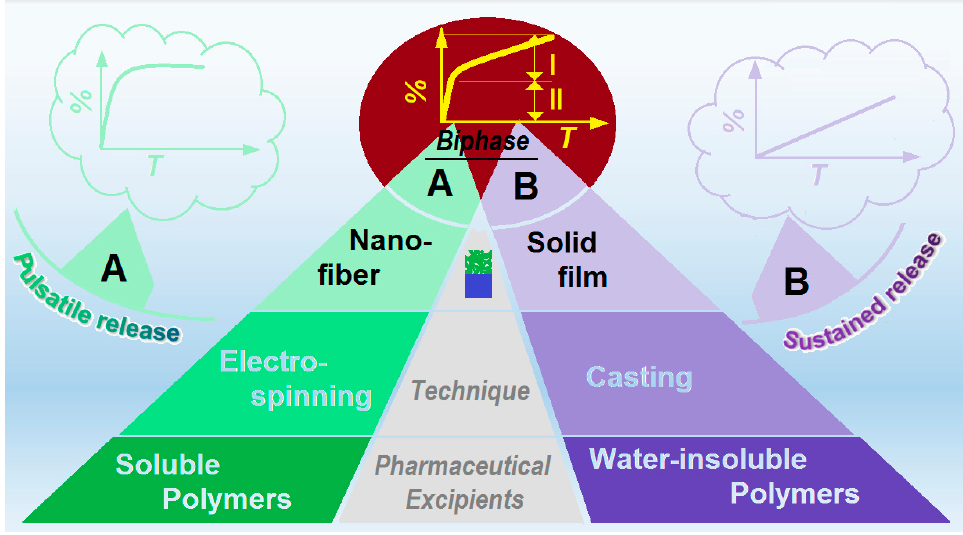
Figure 1. The strategies for preparing polymeric drug delivery systems for providing a dual-phase drug-controlled release.